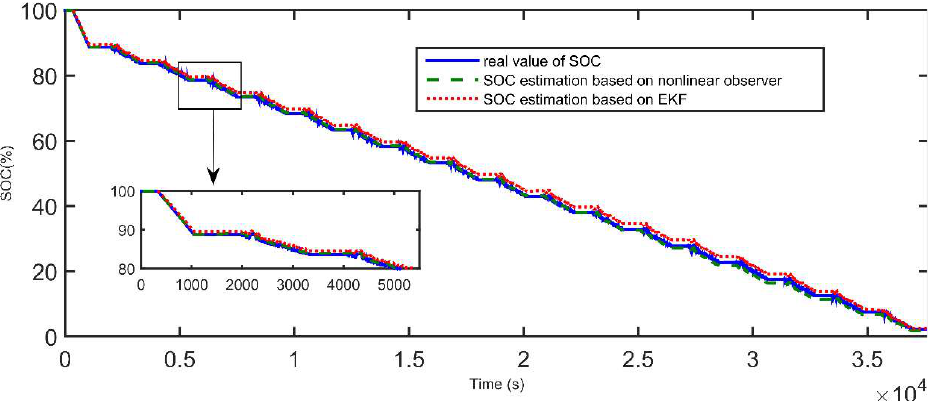
Figure 10. Voltage estimation error of experiment terminal in dynamic condition test 1.